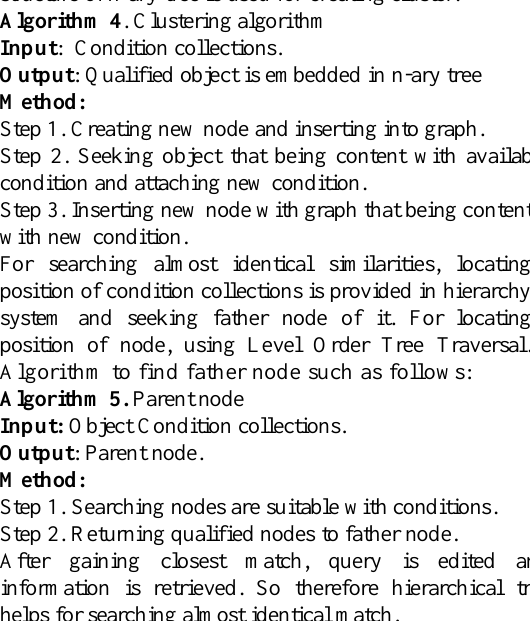
Algorithm 4 . Clustering algorithm